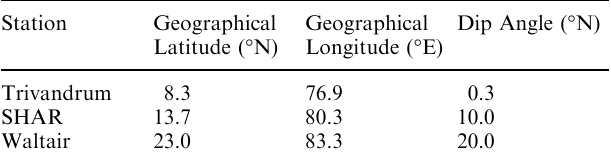
Table 1. Coordinates of the observing stations Station Geographical Latitude ( (cid:176)